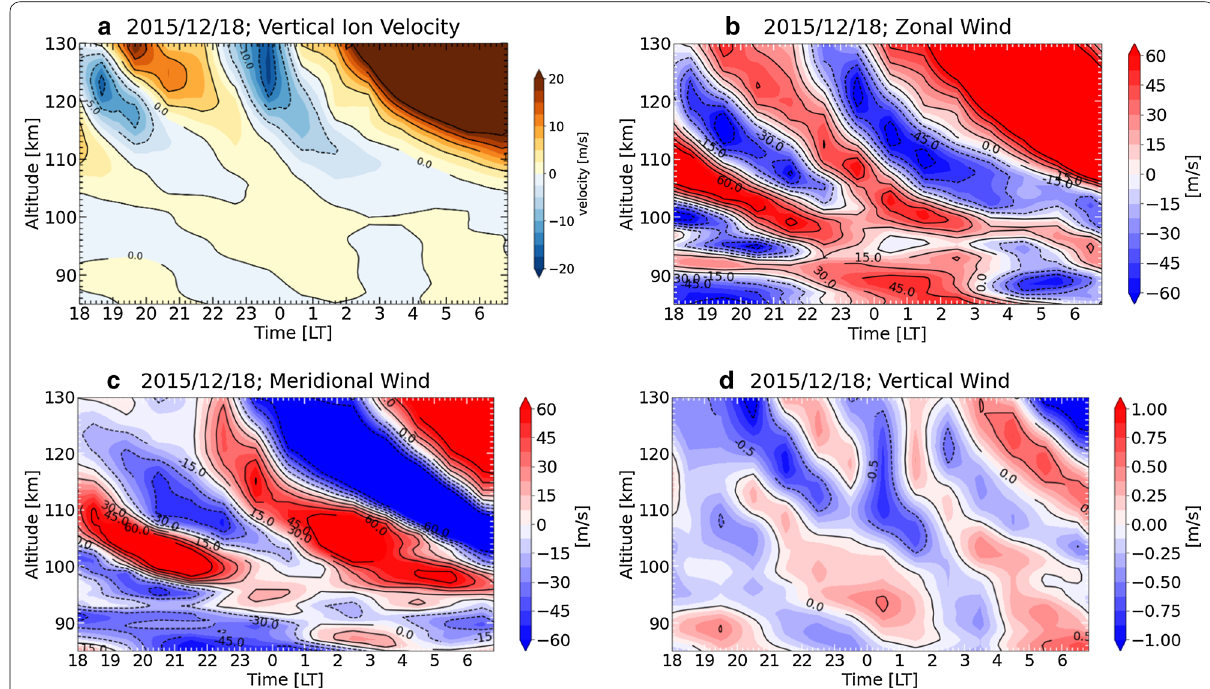
Fig. 3 Temporal variations of ( a ) vertical ion velocity, ( b ) zonal winds, ( c ) meridional winds and ( d ) vertical winds on December 18, 2015. The horizontal axis is same as Fig. 2c–d, but the range of altitude is from 85 km to 130 km altitude and differs from that in Fig.